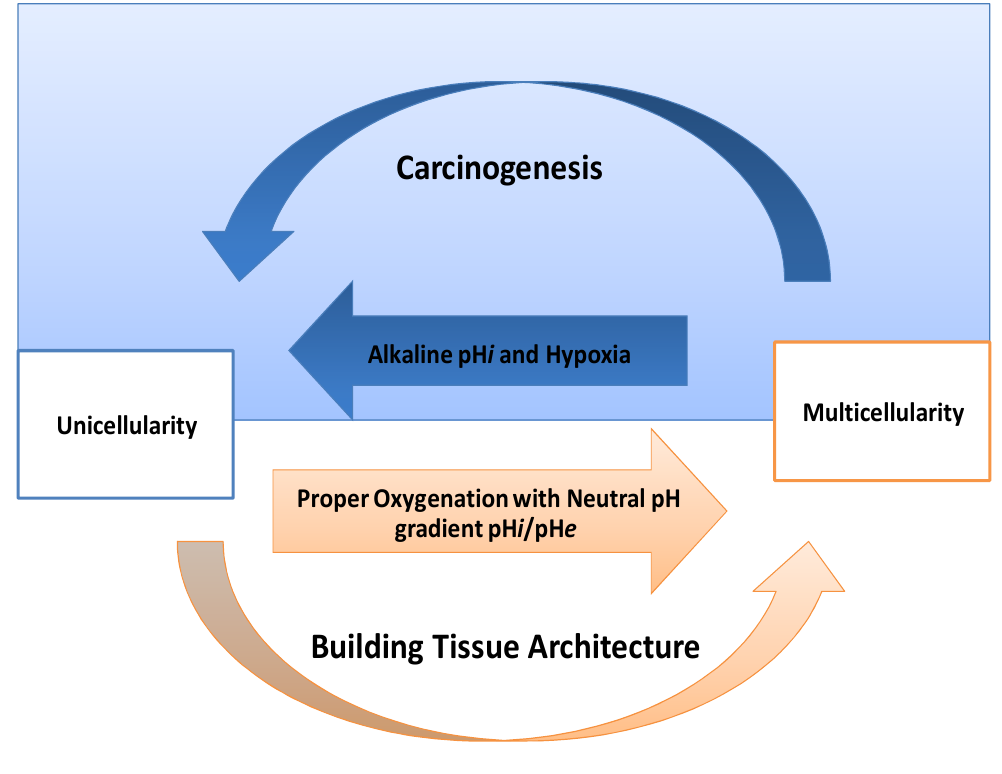
Figure 3. Carcinogenesis as a dismantling of multi-cellularity. Hypothetical model describes the evolutionary homeostasis between prokaryogenesis (carcinogenesis) and eukaryogenesis. The blue background reflects the tumor microenvironment which is the medium where this reverse/convergent evolution